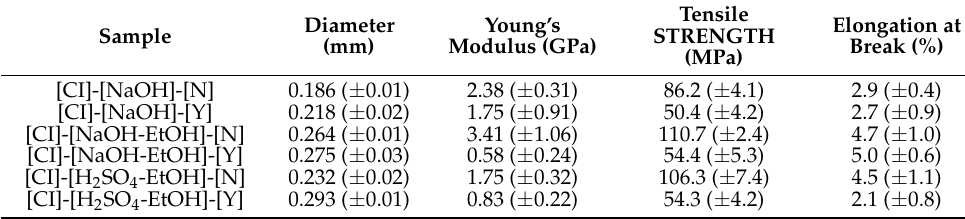
Table 5. Mechanical properties of wet spun monofilaments using citric acid as the